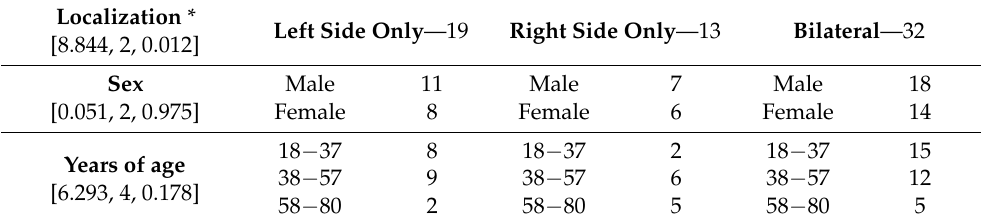
Table 2. Accessory canal localization.